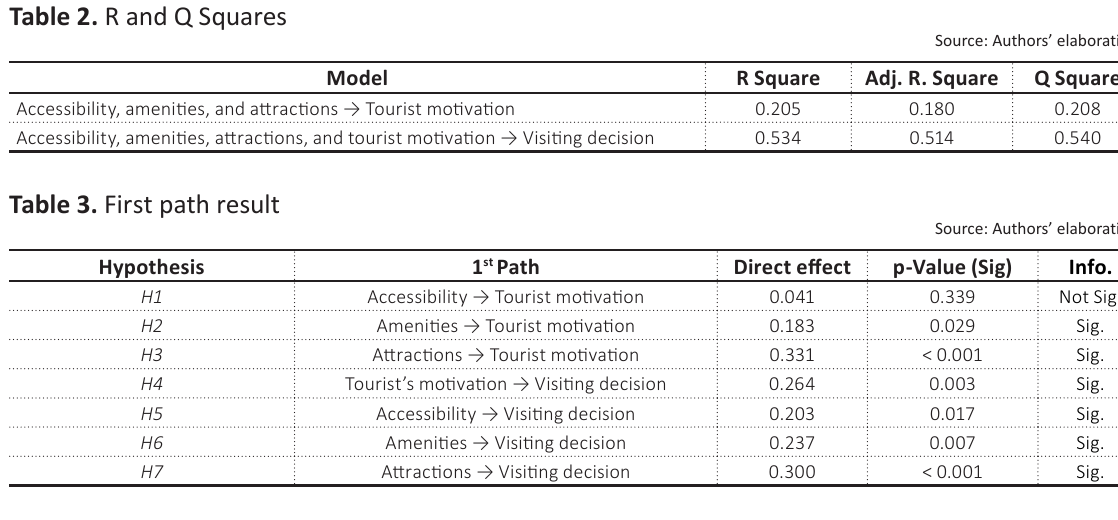
Table 4. Second path